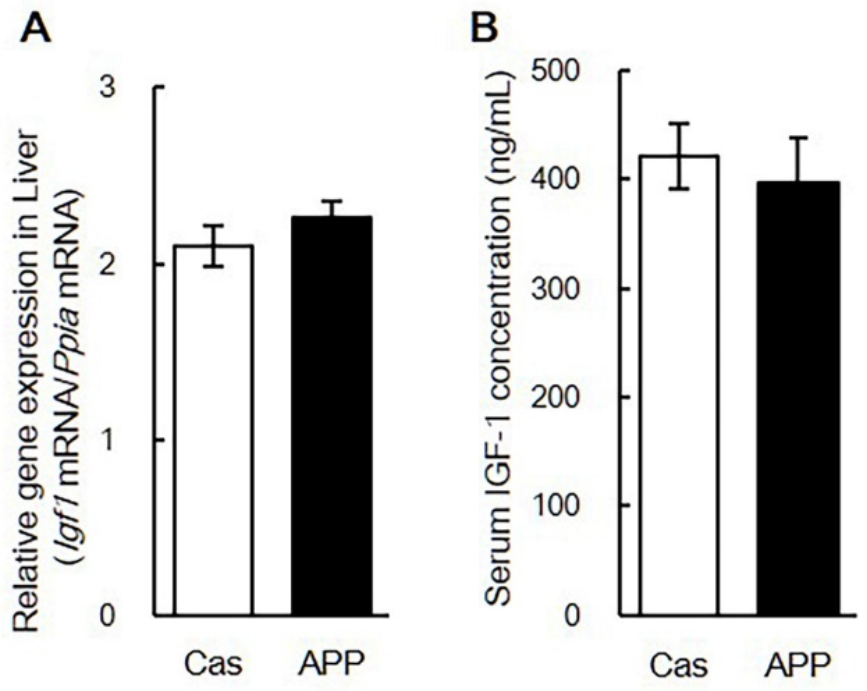
Figure 5. The gene expression of Igf1 in liver and serum concentration of IGF-1 of rats fed a normal- fat casein diet or a normal-fat Alaska pollack protein (APP) diet after 7 days of feeding. The gene expression of Igf1 in liver ( A ) and serum concentration of IGF-1 ( B ) in normal-fat casein diet group (Cas, n = 12) and normal-fat APP diet group (APP, n = 12) after 7 days of feeding are shown. Data are expressed as the mean ± standard error (SEM). Statistical analysis was performed using Student’s unpaired t